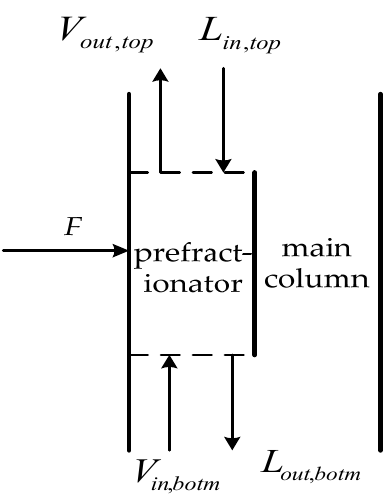
Figure 7. Material balance in Equations (15) and (16).